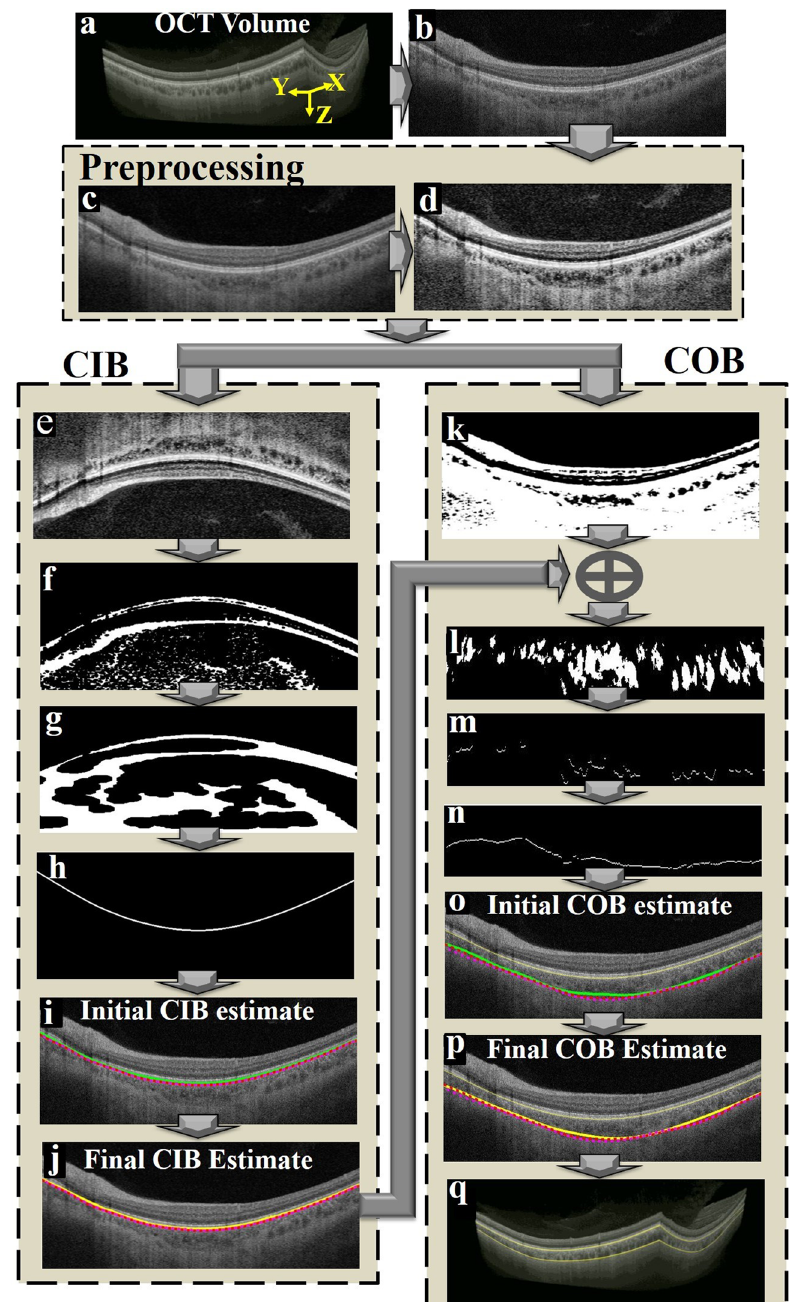
Figure 4. Graphical representation of the proposed algorithm; ( a ) a typical optical coherence tomography (OCT) volume scan; ( b ) a representative B-scan from the OCT volume to illustrate operations performed on a B-scan; ( c ) second order median filtered image; ( d ) adaptive histogram equalization; ( e ) vertically flipped image; ( f ) binarization based on two step exponentiation enhancement; ( g ) morphologically processed image; ( h ) detected CIB; ( i ) initial CIB estimate (green); ( j ) final CIB estimate (yellow); ( k ) binarization based on exponential and non-linear enhancement processes; ( l ) vessel section extracted image based on nal COB and morphological operations; ( m ) identification of extreme point in each column belonging to vessel sections towards sclera; ( n ) interpolation based on 2D tensor voting; ( o ) initial COB estimate (green) vs manual segmentations M1 and M2 (red and magenta); ( p ) final COB estimate (yellow) vs M1 and M2; and ( q ) Segmented boundaries on the whole volume ( CIB choroidal inner boundary, COB choroidal outer